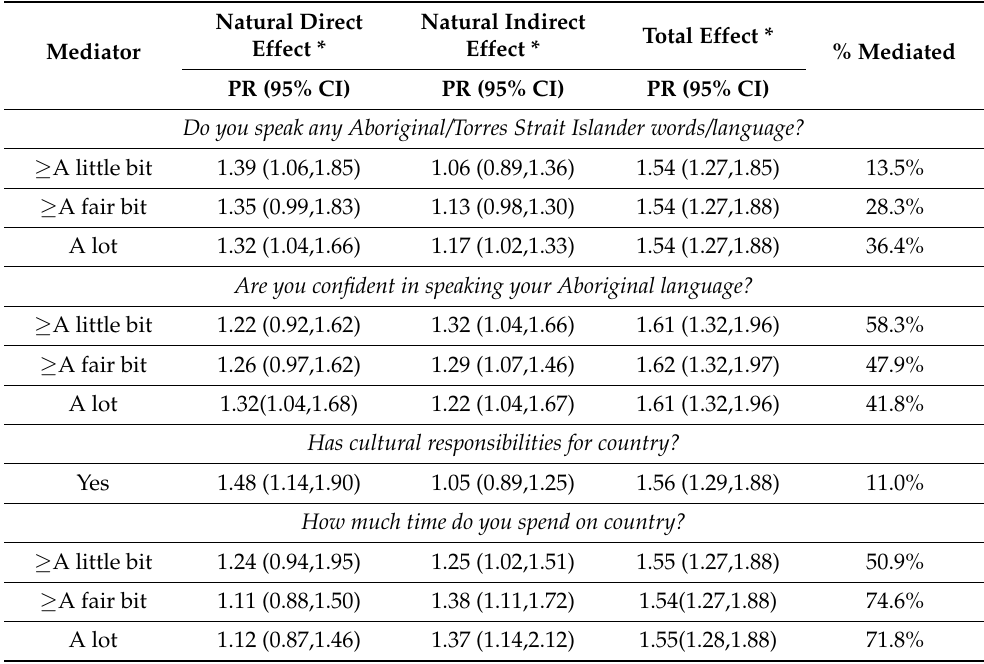
Table 5. Mediation analysis of cultural variables on relationship between Ranger status and very high life